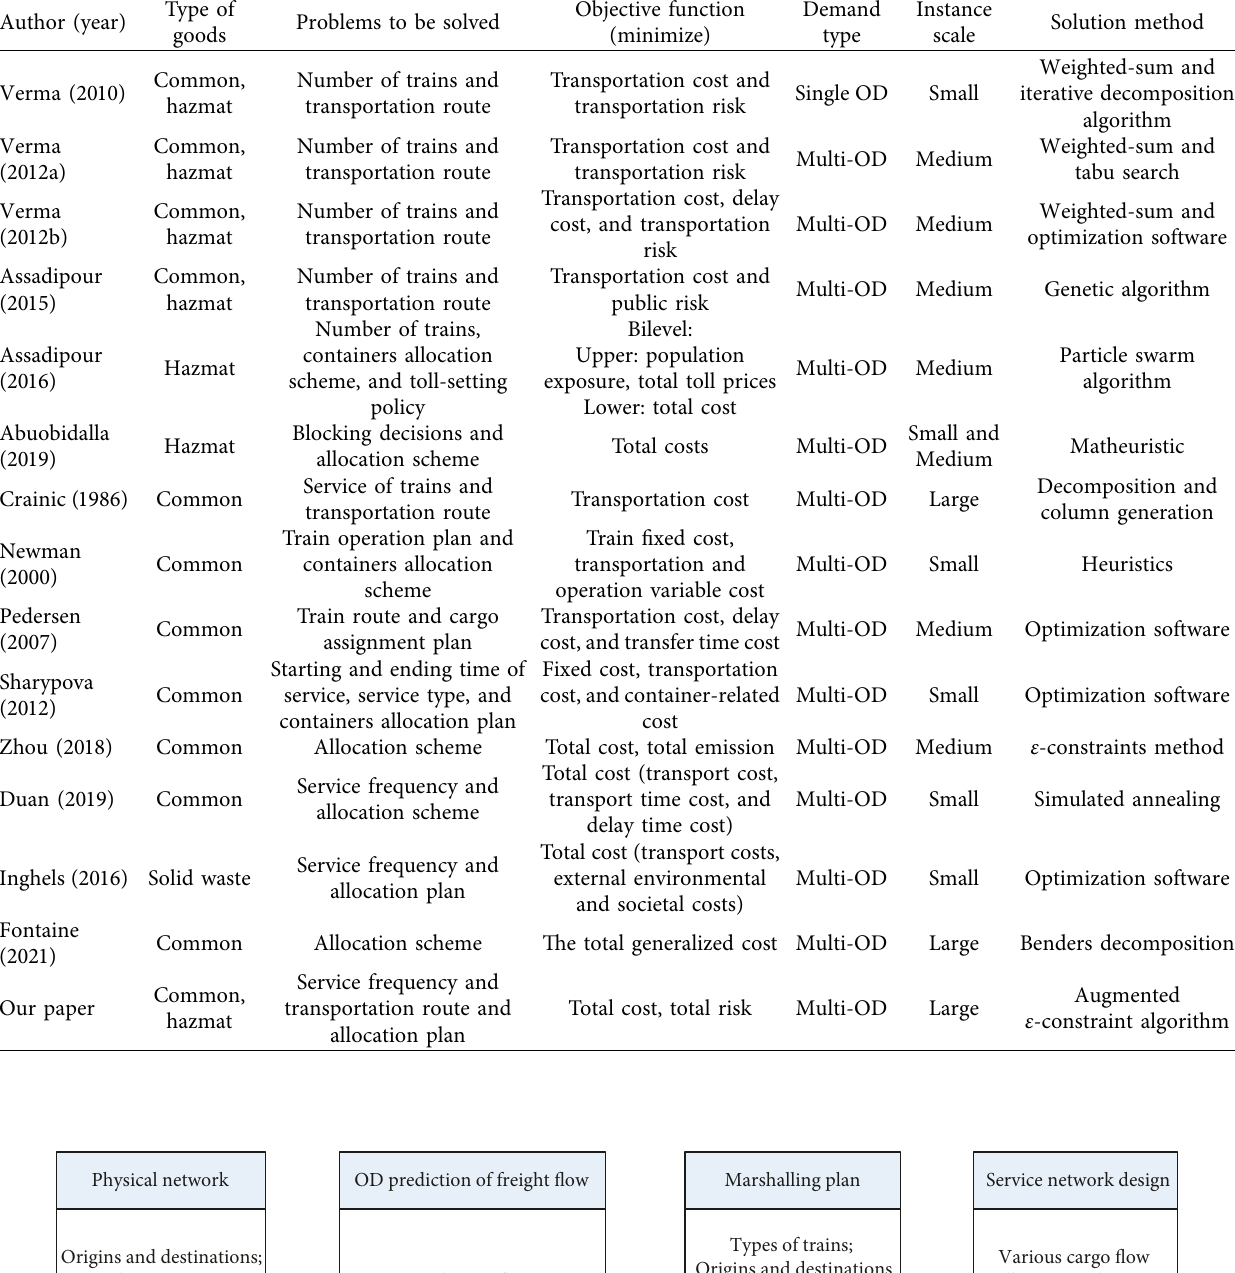
Table 1: Literature review on railroad intermodal transportation network design problem.